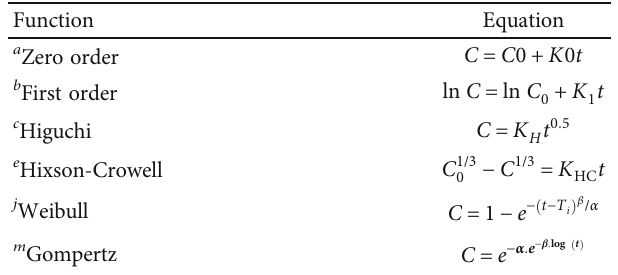
Table 1: Applied statistical models to release data of selegiline.